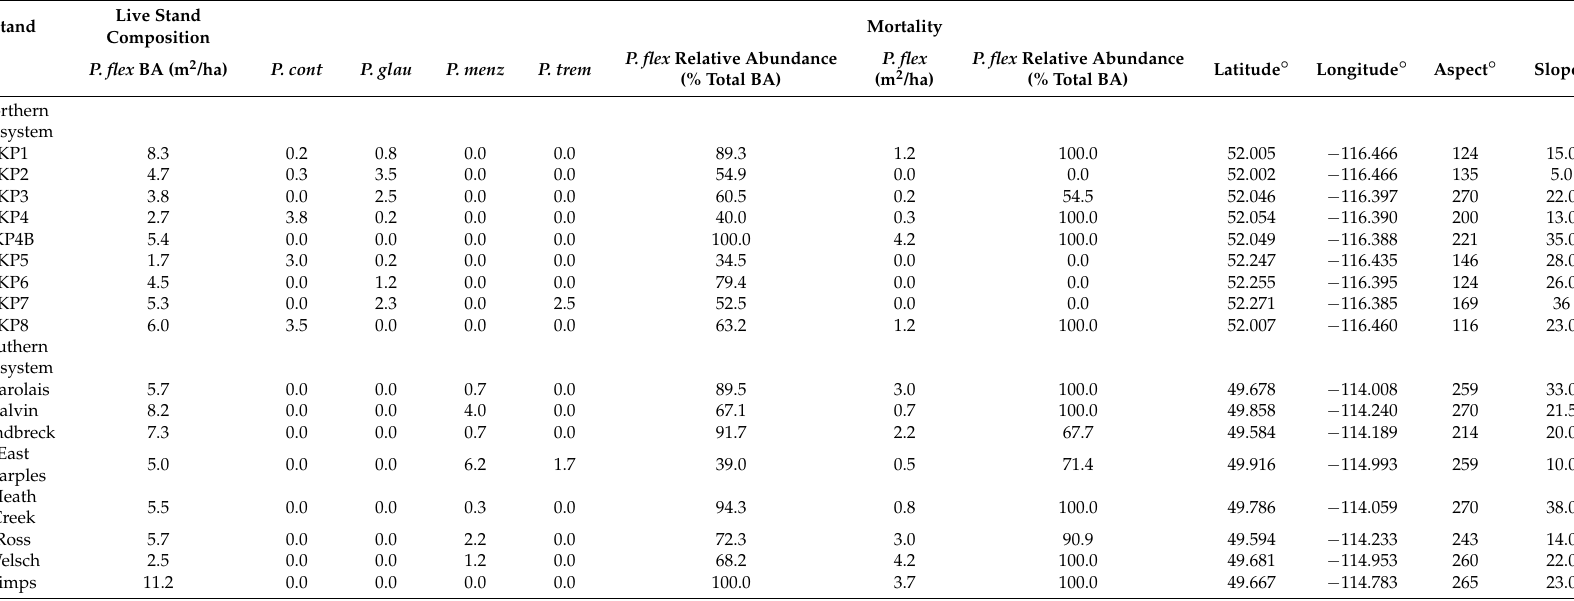
Table 1. Stand structure data and site attributes for study sites used to evaluate recent limber pine regeneration relative to seed availability and substrate conditions. Live trees were tallied separately from standing dead trees in basal area counts